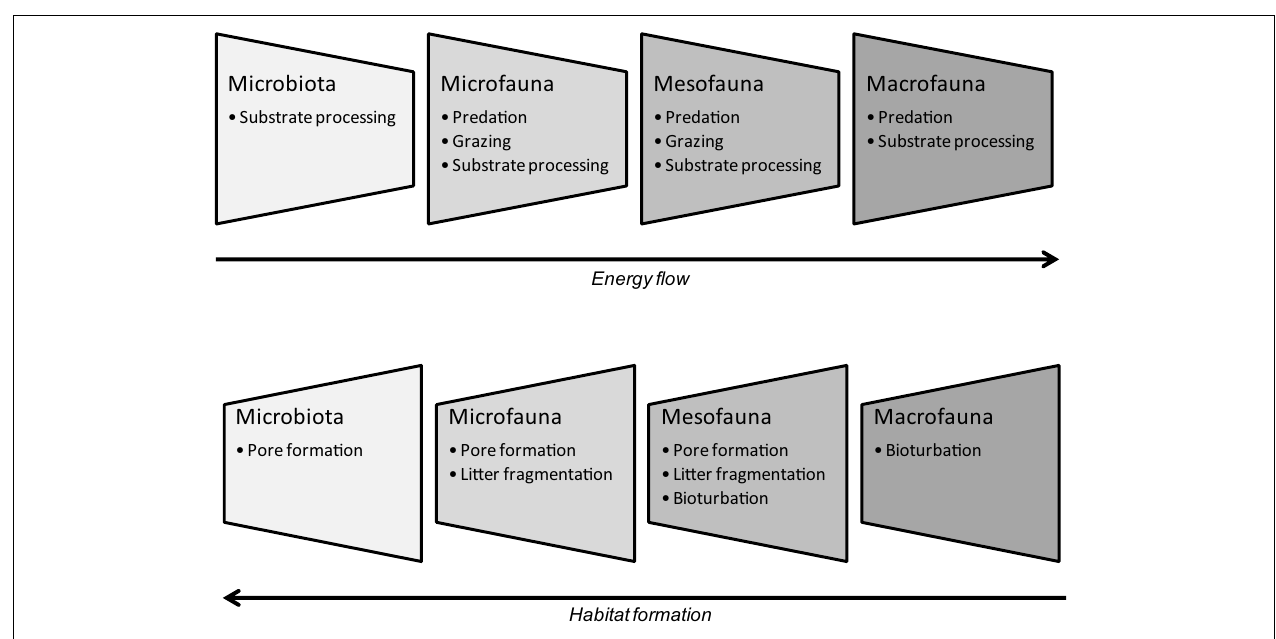
FIGURE 2 | Trophic and engineering interactions among soil organisms based on their body size (adapted from Scheu and Setälä, 2002, with permission from Cambridge University Press).